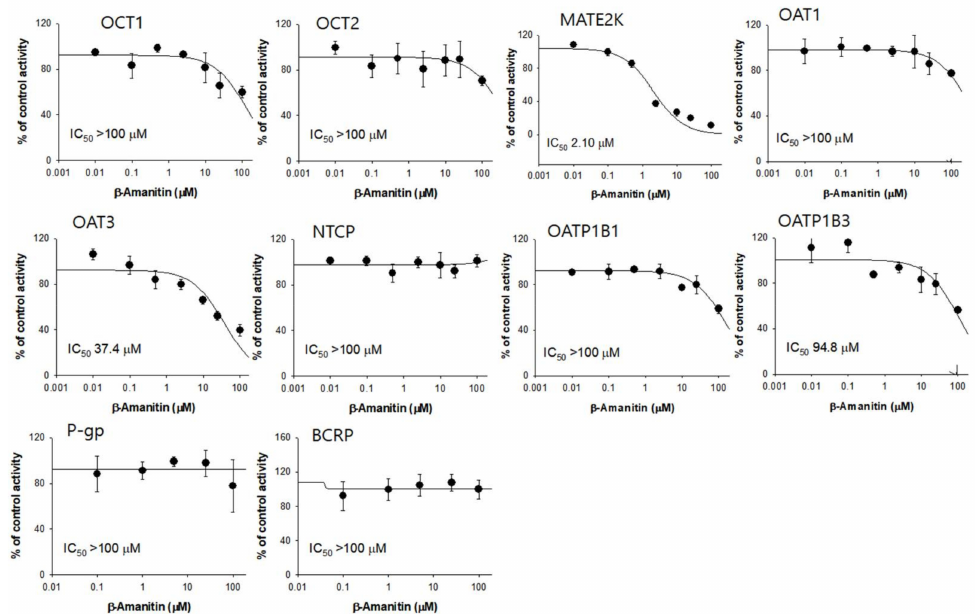
Figure 9. Inhibition of ten major transporters by β -amanitin in HEK293 or LLC-PK1 cells overex- pressing respective transporters. OCT1- or OCT2-mediated [ 3 H]methyl-4-phenylpyridinium uptake in HEK293-OCT1 or -OCT2 cells, MATE2-K-mediated [ 14 C]metformin uptake in HEK293-MATE2-K cells, OAT1-mediated [ 3 H]p-aminohippuric acid uptake in HEK-293-OAT1 cells, NTCP-mediated [ 3 H]taurocholate uptake into HEK293-NTCP cells, OAT3- or OATP1B1-mediated [ 3 H]estrone-3- sulfate uptake in HEK293-OAT3 or –OATP1B1 cells, OATP1B3-mediated [ 3 H]17- β -D-estradiol- glucuronide in HEK293-OATP1B3 cells, P-gp-mediated [ 3 H]digoxin transport in